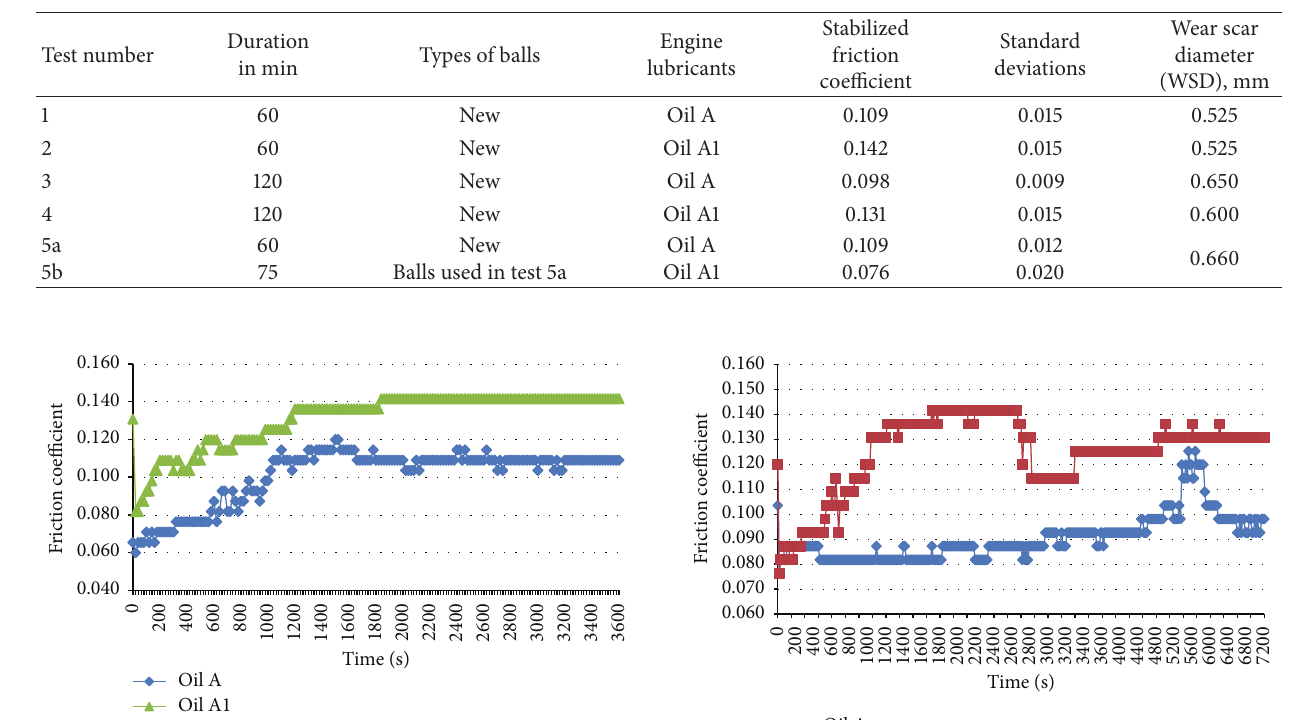
Table 3: Stabilized friction coefficient and wear scar diameter.